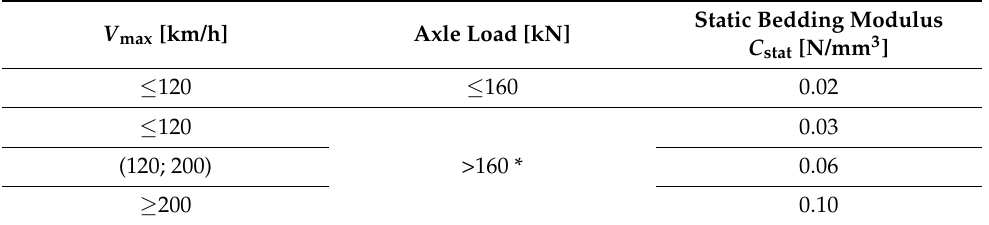
Table 2. Requirements for static bedding moduli of UBM used as vibration isolators, according to DB regulations